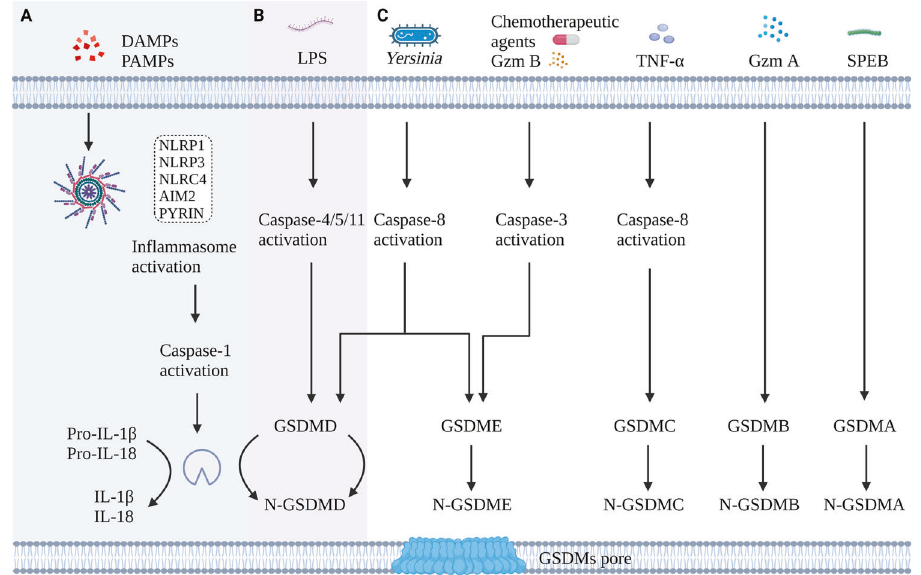
Fig. 1 Molecular mechanism of pyroptosis. A Canonical pathway. In the canonical pathway, pathogens lead to in fl ammasome formation and activation of caspase-1, which subsequently cleaves GSDMD and promotes IL-1 β /IL-18 maturation. GSDMD-N-terminal domain forms pores in the plasma membrane, further resulting in cell lysis and IL-1 β /IL-18 release. B In the noncanonical pathway, caspase-4/5/11 is activated by cytosolic LPS, triggering pyroptosis by cleaving GSDMD. C Yersinia , TNF- α signaling, Gzm B, and chemotherapeutic drugs involve in the activation of caspase-8 and caspase-3, which induce pyroptosis through cleavage of GSDMC, GSDMD, or GSDME. In addition, Gzm A, Gzm B, and SPEB also cause pyroptosis by directly cleaving GSDMB, GSDME, and GSDMA,